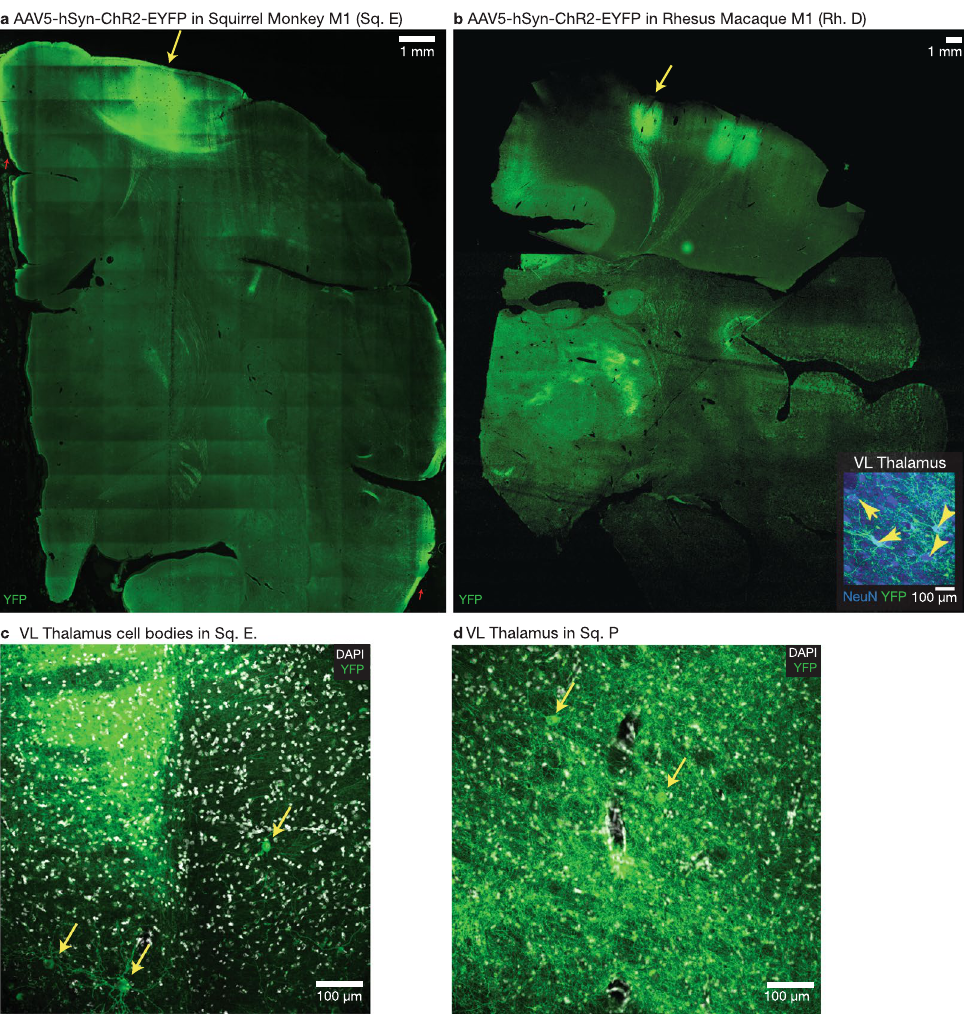
Figure 3. Retrograde transduction in both squirrel monkey and rhesus macaque. In both squirrel monkey and rhesus macaque, AAV5 expresses in cell bodies in the ventral lateral (VL) nucleus of the thalamus, suggesting viral uptake and retrograde transduction in thalamocortical axons. ( a ) AAV5-hSyn-ChR2(H134R)-EYFP injected in Sq. E left M1 at the site indicated by yellow arrow. Autofluorescence along the midline and edges of the tissue, indicated with red arrows, is due to aberrations in slide mounting rather than opsin expression. ( b ) AAV5-hSyn-ChR2(H134R)-EYFP injected in Rh. D in right M1 at the site highlighted by yellow arrow. Inset: Expression in cell bodies in VL thalamus, highlighted with yellow arrows. ( c ) Expression in cell bodies in VL thalamus of Sq. E, highlighted with yellow arrows. ( d ) Expression in cell bodies in VL thalamus of Sq. P, also injected with AAV5-hSyn-ChR2(H134R)-EYFP in left